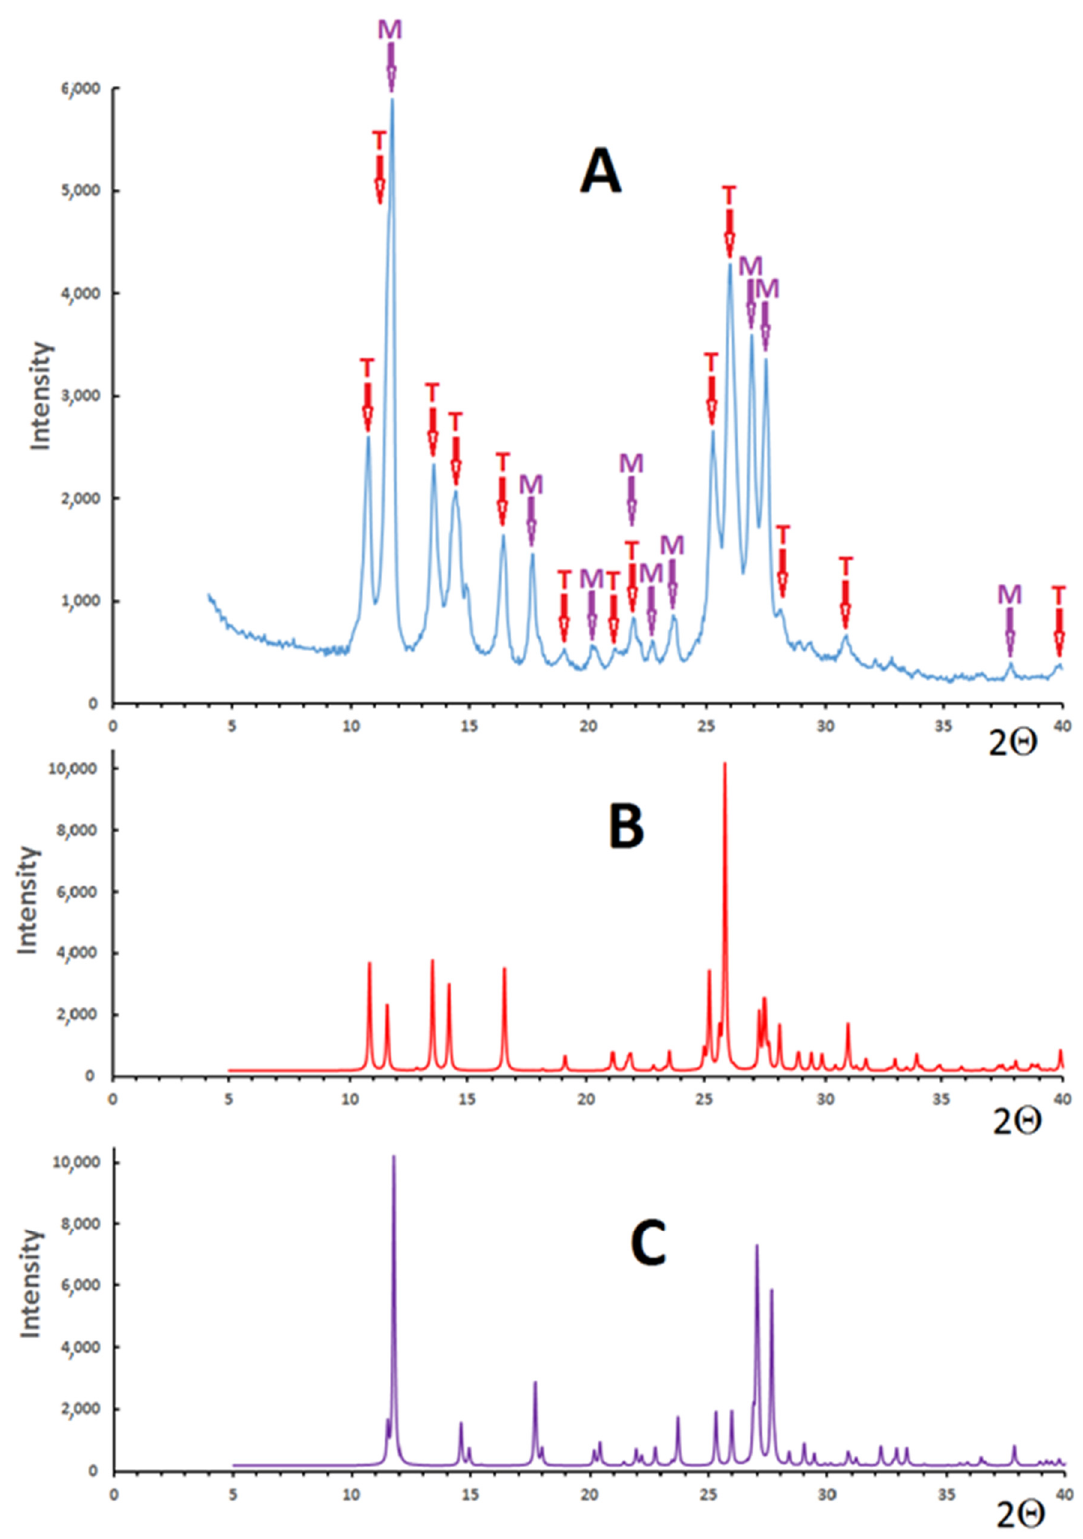
Figure 4. ( A ) experimentally recorded diffractogram of dioxidine obtained with a carrier gas (CO 2 ) flow of 7.0 × 10 16 , ( B ) theoretical diffractogram of dioxidine triclinic phase (T-phase) [41], ( C ) theoretical diffractogram of dioxidine monoclinic phase (M-phase) [41].